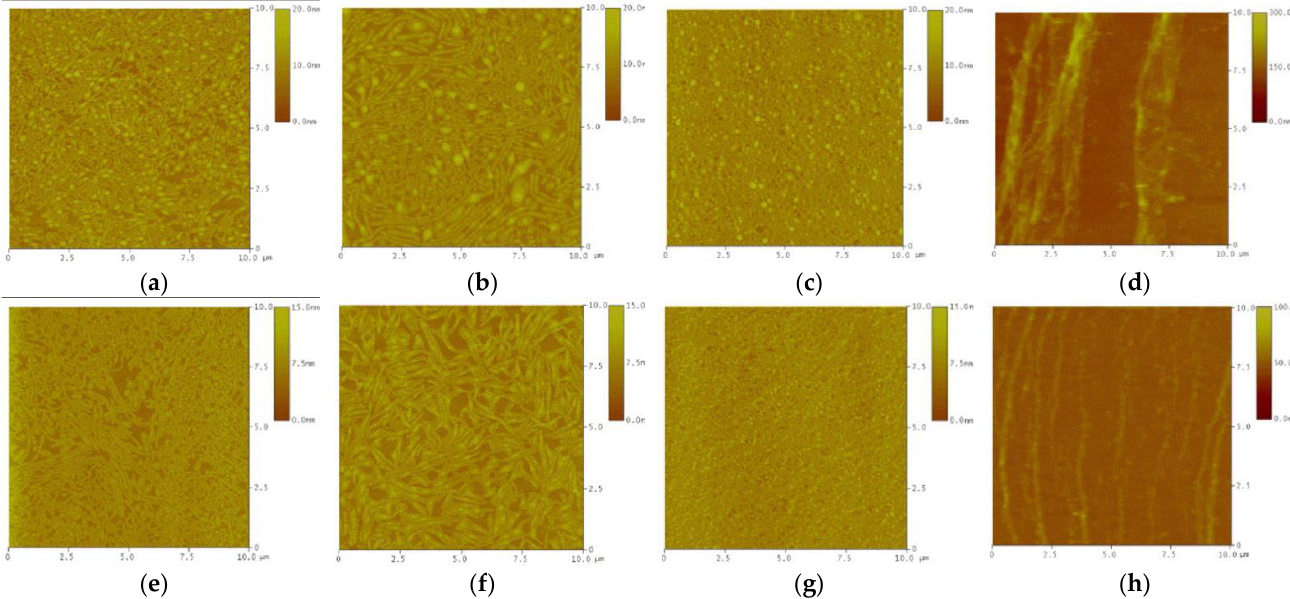
Figure 3. AFM images of monolayer LB films of high and low molecular weight asphaltene frac- tions deposited at different surface pressures π using the Langmuir-Blodgett method. ( a ) high- molecular-weight, π =0 mN/m. ( b ) high-molecular-weight, π =5 mN/m. ( c ) high-molecular-weight, π =30 mN/m. ( d ) high-molecular-weight, π =70 mN/m. ( e ) low-molecular-weight, π =0 mN/m. ( f ) low-molecular-weight, π =5 mN/m. ( g ) low-molecular-weight, π =30 mN/m. ( h ) low-molecular- weight, π =65 mN/m. Reprinted with permission from [50]. Copyright © 2022 Elsevier.